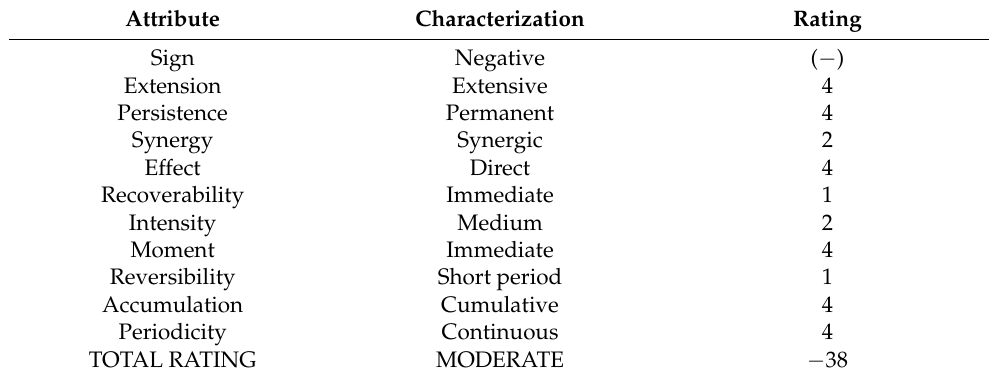
Table 8. Assessment of the impact on marine